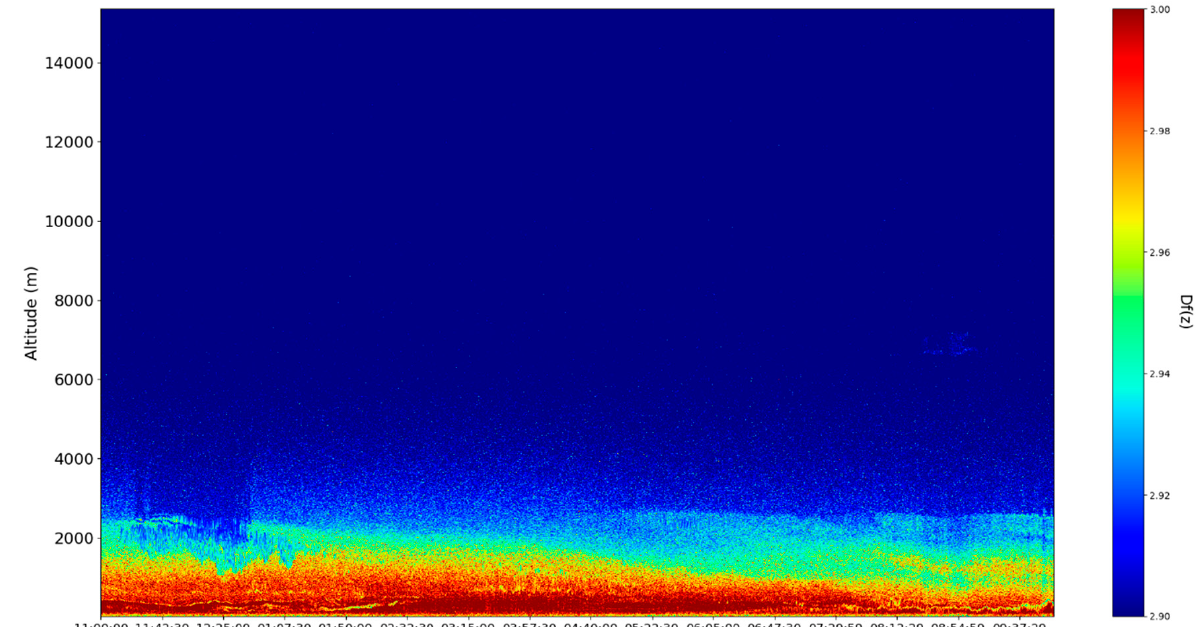
Figure 23. D f time series, λ = 1064 nm, Galat i, Romania, 22 December 2021. Figure 23. D (cid:2916) time series, λ = 1064 nm , Gala ț i, Romania, 22 December 2021. Figure 23. D (cid:2916) time series, λ = 1064 nm , Gala ț i, Romania, 22 December 2021. ,